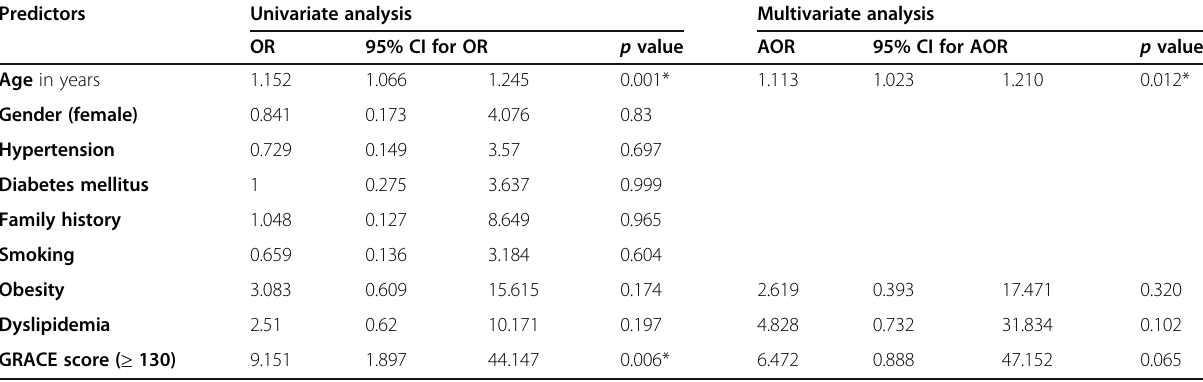
Table 3 Univariate analysis and multivariate analysis for 6 months mortality